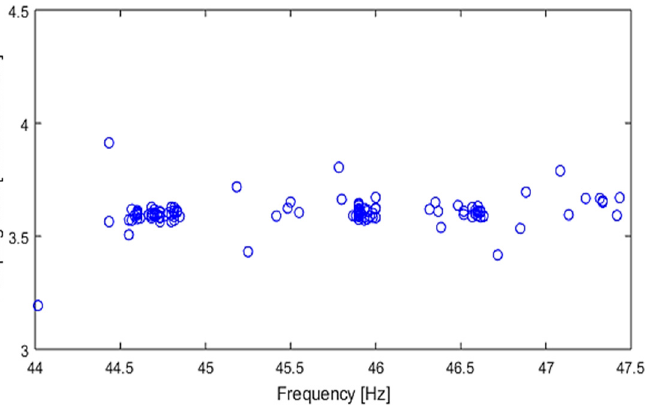
Figure 15. The characteristic F = f ( C_p i,n ) for the hydraulic regime with three pumps in operation.